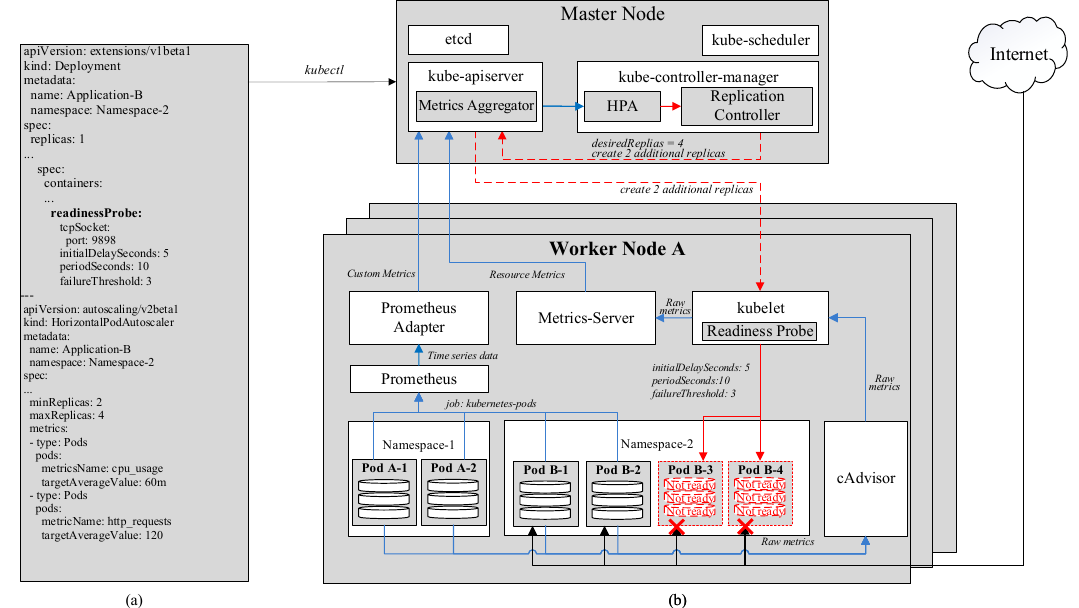
Figure 2. ( a ) Examples of YAML code for configuring HPA and Readiness Probe in Kubernetes. ( b ) Horizontal Pod Autoscaling’s (HPA)